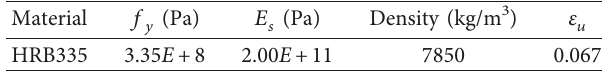
Table 2: Mechanical properties of HRB335.